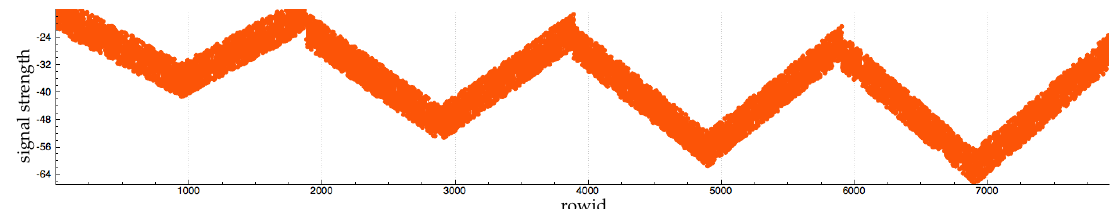
Figure 5. Evolution of RFID signal strength. In rows [0–2000], the tag is approximately 1 m away from the antenna. In rows [2000–4000], the tag is approximately 4 m away from the antenna. In rows [4000–6000], the tag is approximately 10 m away from the antenna. In rows [6000–8000], the tag is approximately 10 m away from the